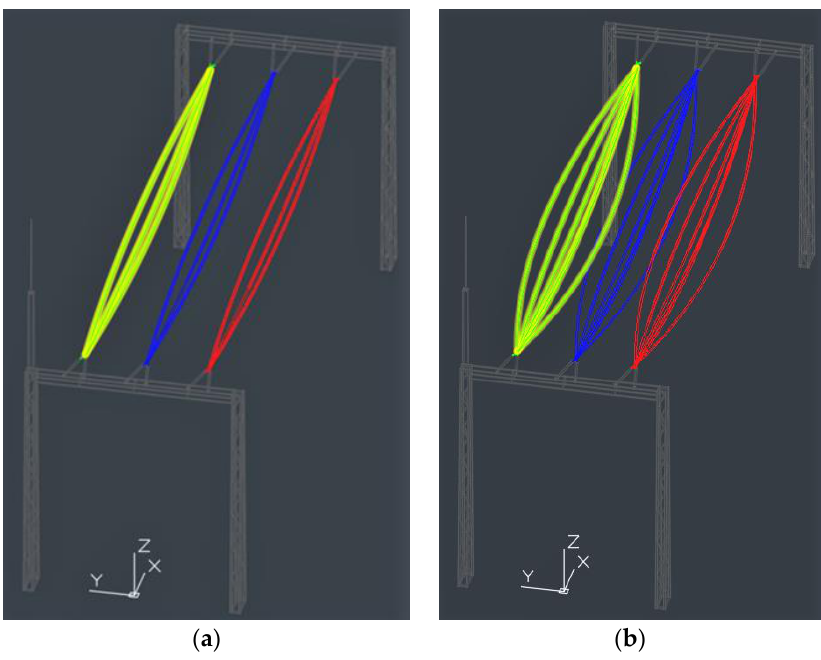
Figure 10. Simulation of wire movement during short-circuit: ( a ) during; ( b ) after.